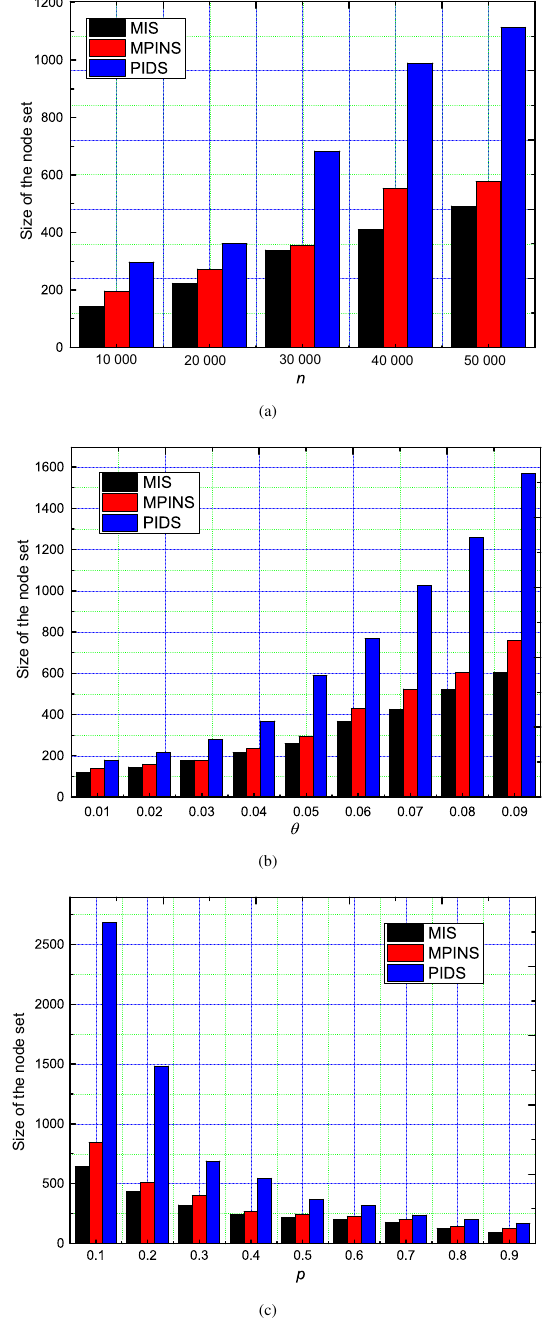
Fig. 9 Size of the node set: (a) (cid:18)(cid:18)(cid:18) = 0.02 and p = 0.2, (b) n = 50 000 and p= 0.2, (c) (cid:18)(cid:18)(cid:18) = 0.02 and n = 50000. which is shown in Table 1, comes from the Stanford Large Network Dataset Collection (SNAP) ‘ , which is a platform for open network data sets collected and maintained by Stanford University. The